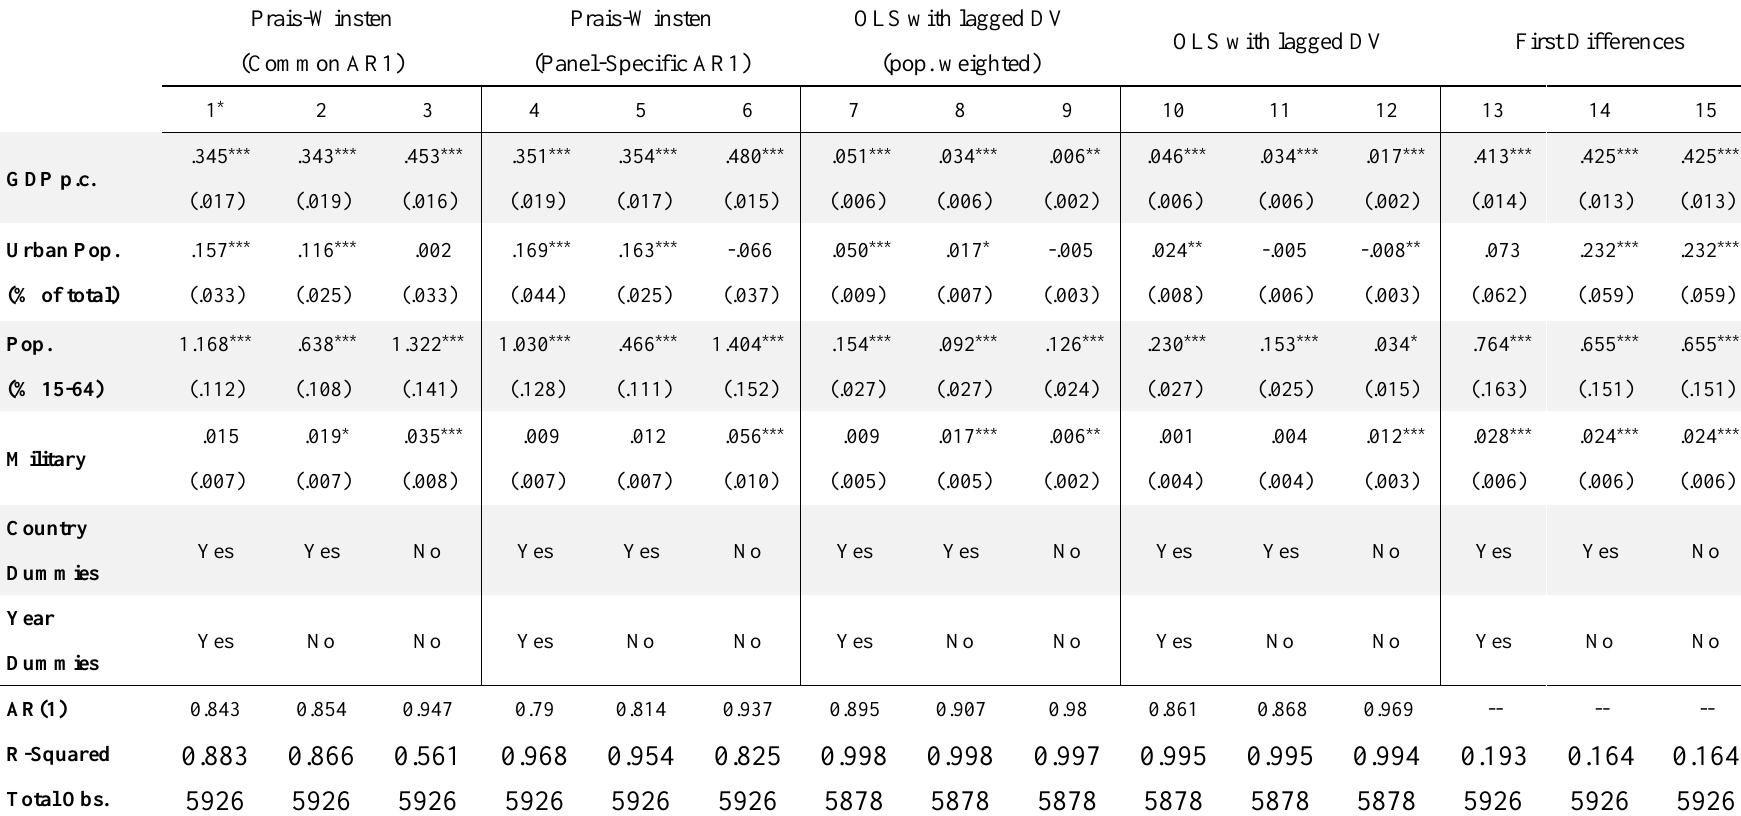
Table 5 . Comparison of Different Model Specifications (Unbalanced Panels –